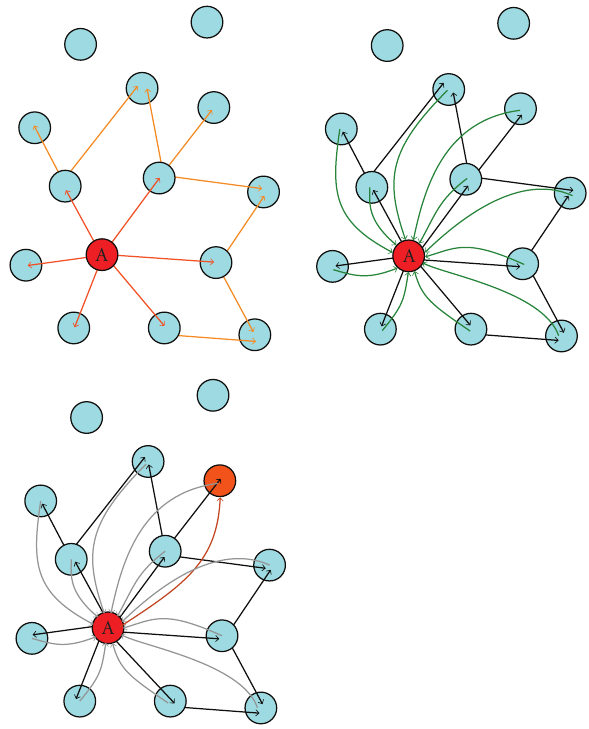
Figure 6: LMGS: issue a request (top left picture), retrieve answers (top right picture), and commission job (bottom left